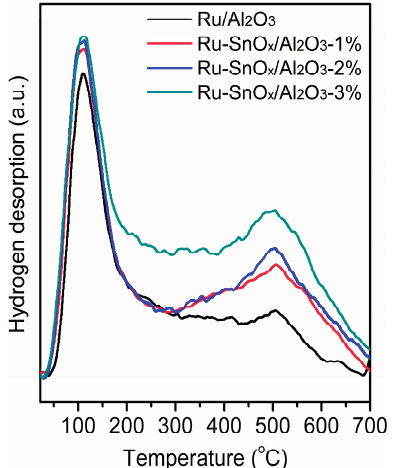
Figure 5. The H -TPD profiles of the supported Ru 2